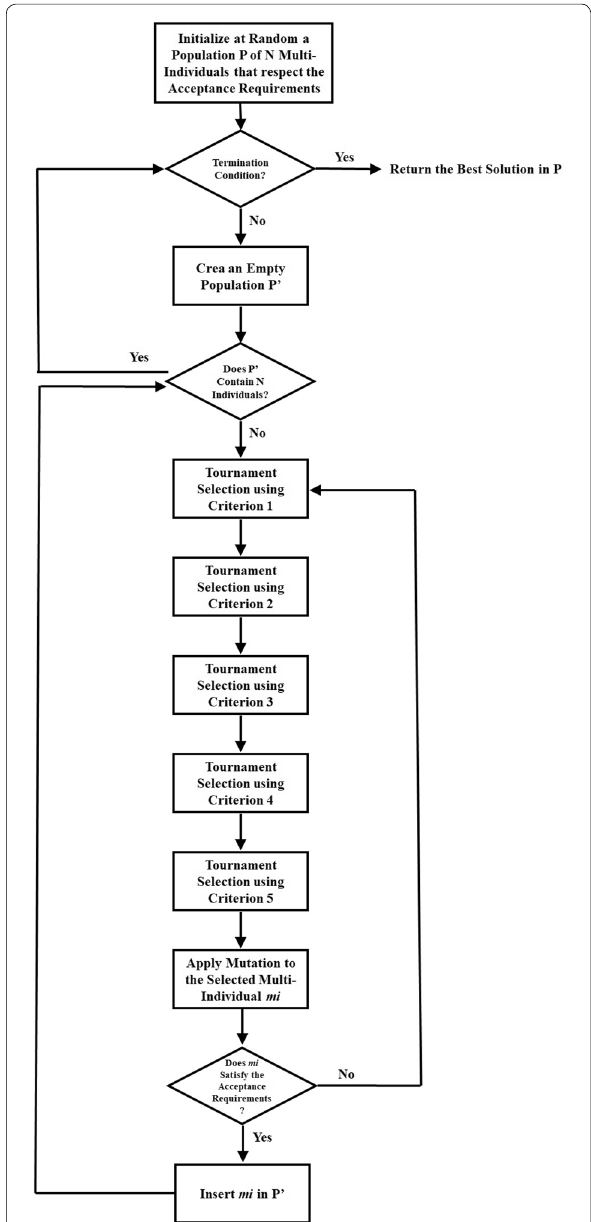
Fig. 6 High level flowchart of NAGP (see the text for a definition of the acceptance